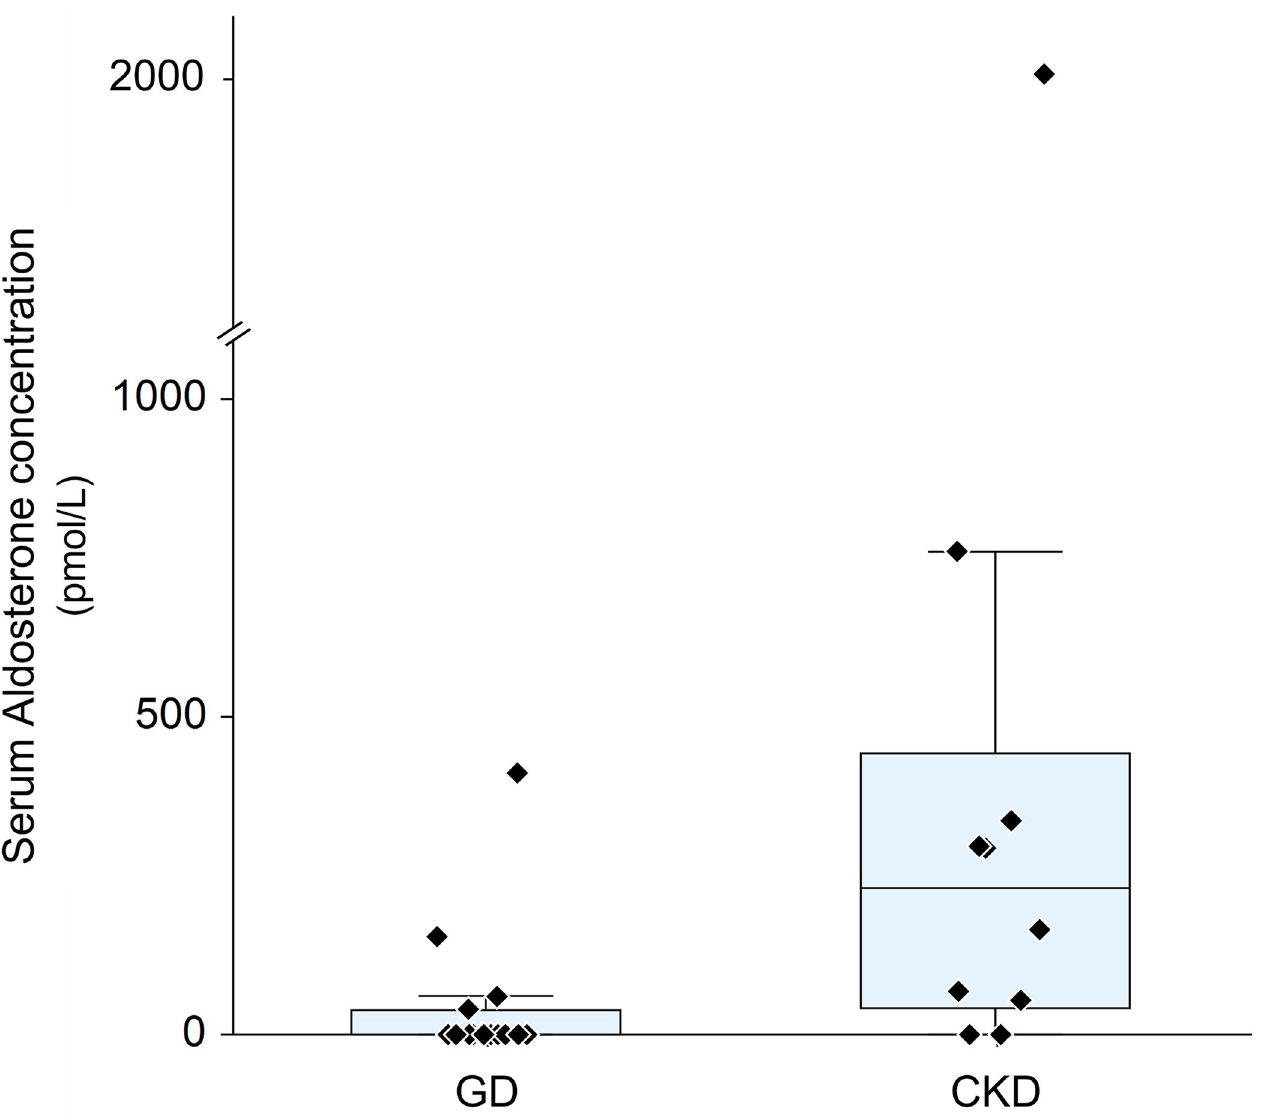
Fig 1. Serum aldosterone concentration. GD = Glomerular disease, CKD = chronic kidney disease. Each diamond represents 1 dog.